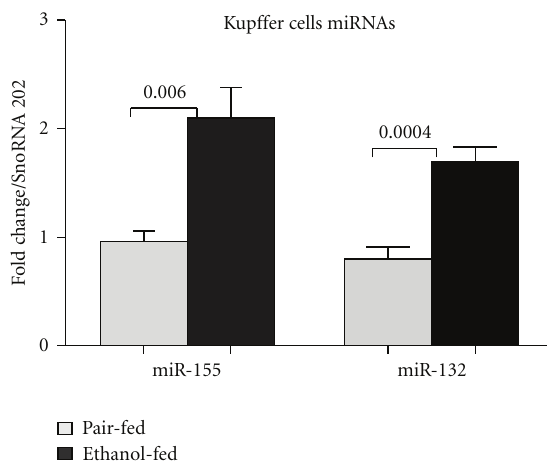
Figure 3: Upregulation of miR-155 and -132 in Kup ff er cells of alcohol-fed mice. Kup ff er cells were isolated either from pair-fed or alcohol-fed mice ( n = 12–14/group, cells from two mice were pooled) after 4 weeks of feeding. Cells were plated and after 2 h of incubation nonadherent cells were removed. Fresh medium was added to the adherent, and they were rested overnight. Next day, cells were washed with PBS and lysed with QIAzole (Qiagen). Total RNA isolated using the miRNeasy kit was used quantify miRNA as described above. Data represent mean values ± S.E.M. Statistical significance was determined using T-test